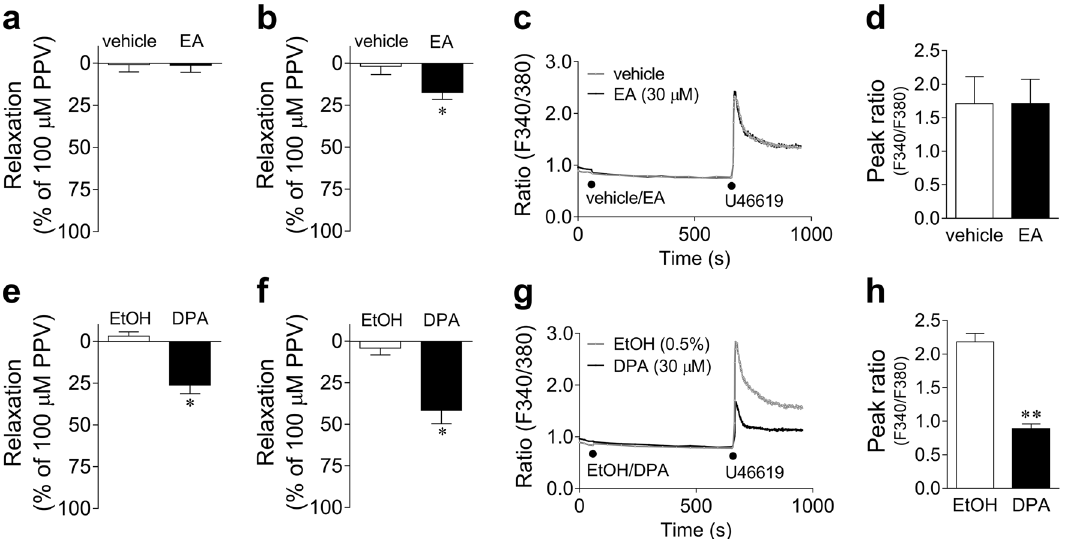
Figure 8. Quantified data of relaxant responses to 30 μM eicosanoic acid (EA) ( a , b ) and 30 μM docosapentaenoic acid (DPA) ( e , f ) on the contractions induced by 10–30 nM U46619 for porcine basilar ( a,e ) and coronary ( b , f ) arteries. Changes in Fura-2 fluorescence intensity ratio (F340/380) induced by 10 nM U46619 ( c,g) in the presence of 30 μM EA or its vehicle (0.05% dimethylformamide/0.45% EtOH) ( c ) or 30 μM DPA or its vehicle (0.5% EtOH) ( g ) in TP-293T cells; quantified data of the F340/380 peak ratio after application of U46619 ( d , h ). Changes in F340/380 are presented as means only ( c,g ), and quantified data are presented as mean ± SEM [n = 6 ( a ), n = 5 ( b ), n = 10 ( c , d ), n = 7 ( e ), n = 6 ( f ), and n = 10 ( g , h )]. ● : each drug application. *P < 0.05, **P < 0.01 versus EtOH or vehicle (Student’s t -test). PPV: papaverine; EtOH: